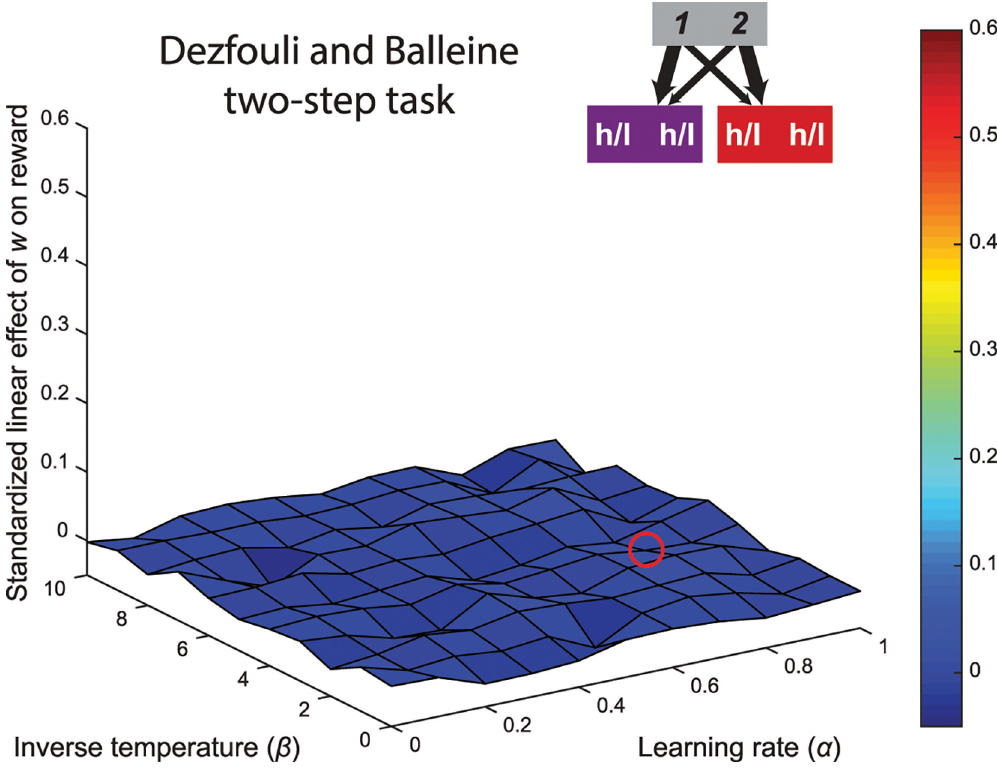
Fig 4. Surface plot of the linear relationship between the weighting parameter and reward rate in the Dezfouli and Balleine version of the two-step task. The red circle shows the median fit. Similar to the Daw variant, this task does not capture a trade-off between accuracy and demand across all tested